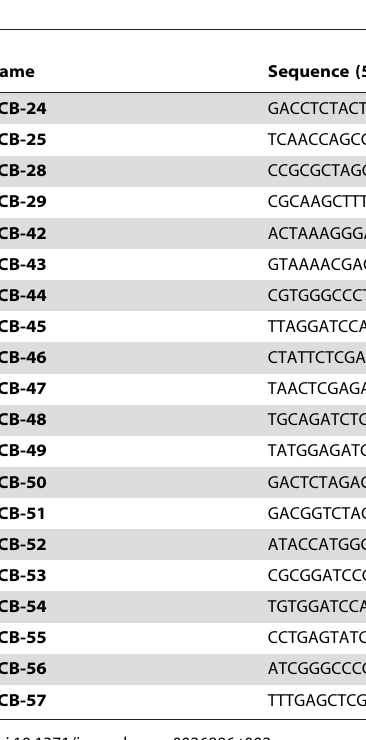
Table 2. Primers were used in this